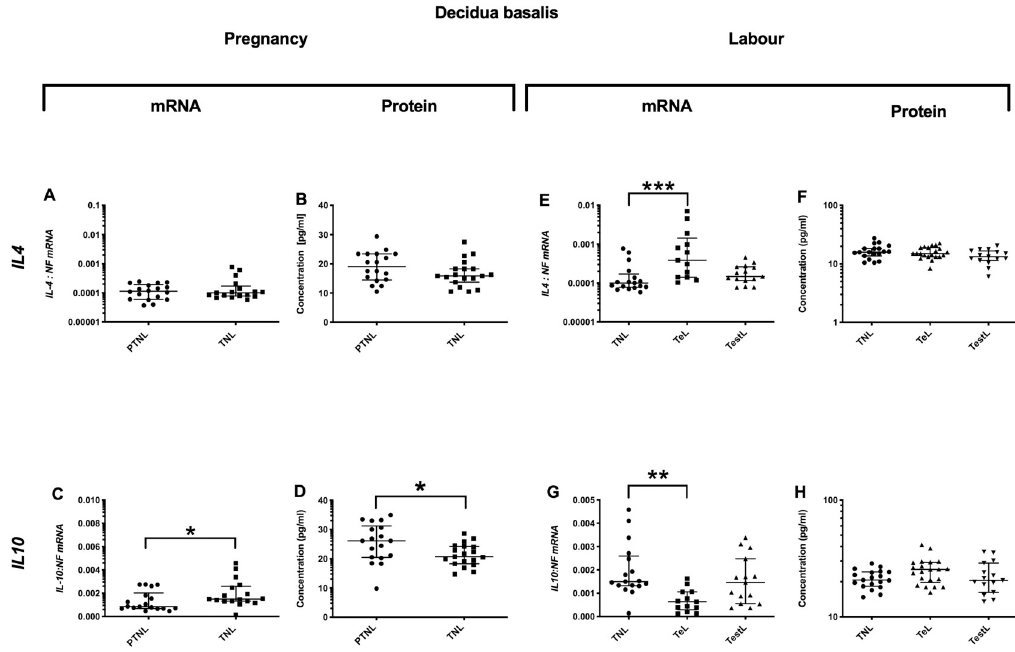
n = 17), TNL (39.3 ± 0.9 weeks, n = 16), TeL (38.6 ± 1.2 weeks, n = 13) and TestL (39.5 ± 1.0, n = 15) were used to compare the mRNA expression using rtPCR of IL4 and IL10 . Normally distributed data were analysed using a Student’s t-test and for